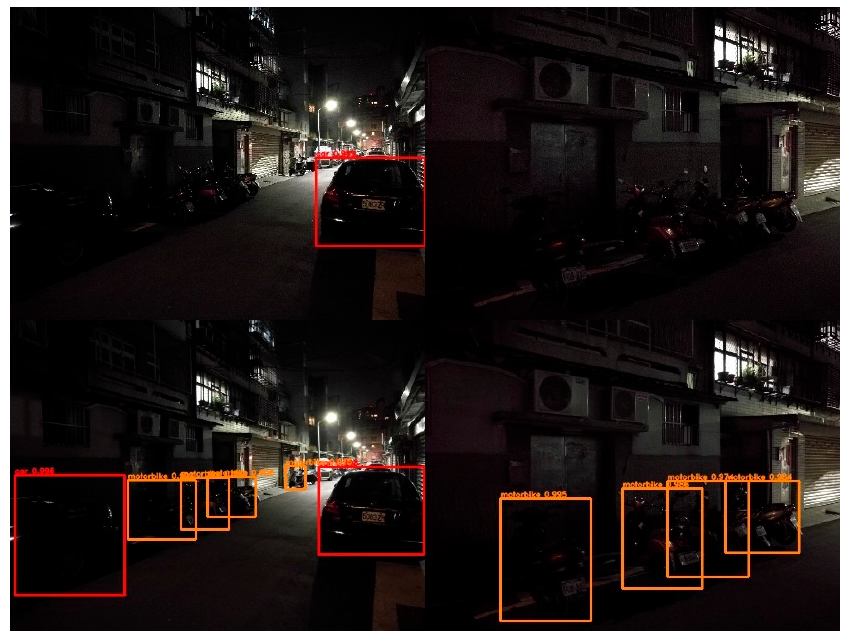
Figure 2. Urban nighttime images processed by the Faster R-CNN [5] with ResNet101 [2] trained using PASCAL VOC 2007 [6].